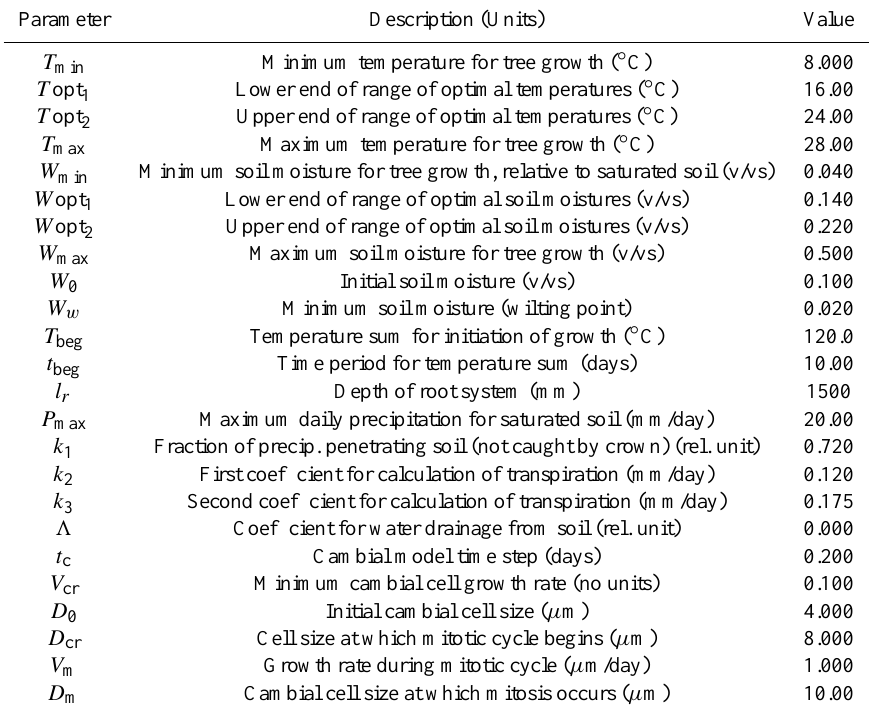
Table 1. Optimal model parameters 1 estimated calibration of VS model over period 1982–2004.